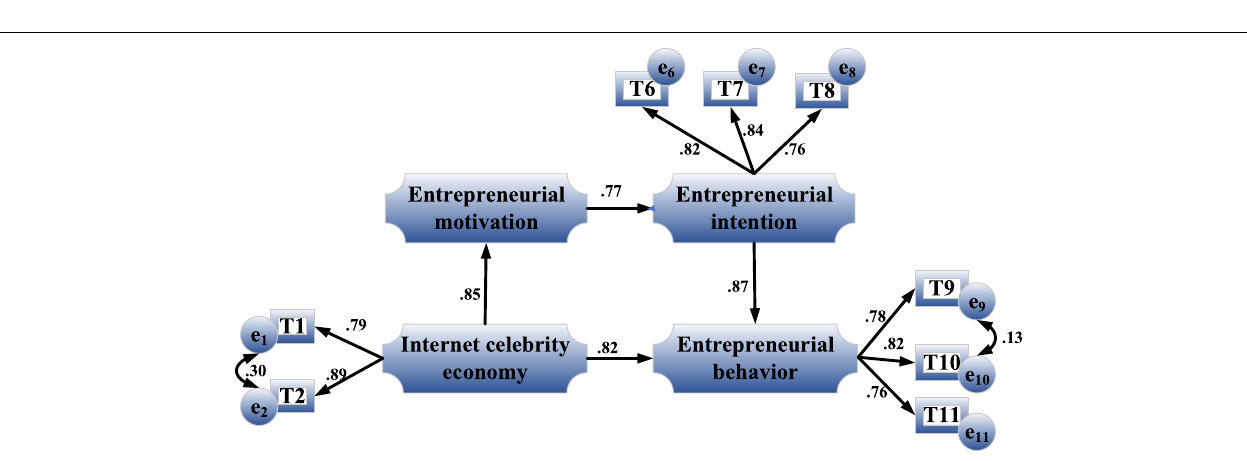
FIGURE 13 | Path coefficient diagram of the indirect impact of the Internet celebrity economy with entrepreneurial motivation and entrepreneurial intention as the chain double mediating on entrepreneurial behavior.